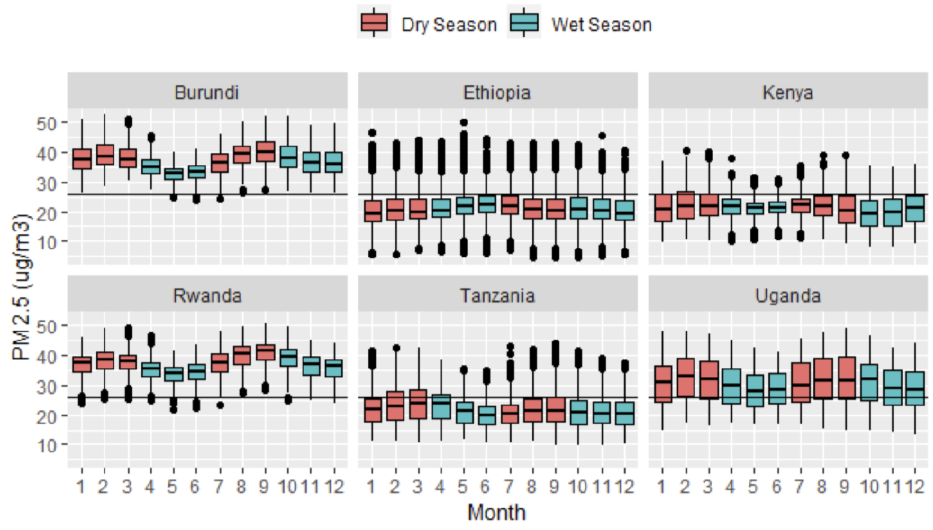
Figure 2. Seasonal trend of prenatal PM 2.5 exposures stratified by child’s month of birth and by country. The horizontal black line shows the overall PM 2.5 population average (25.83 µ g/m 3 ), five times above the WHO annual recommended maximum level of 5 µ g/m 3 .